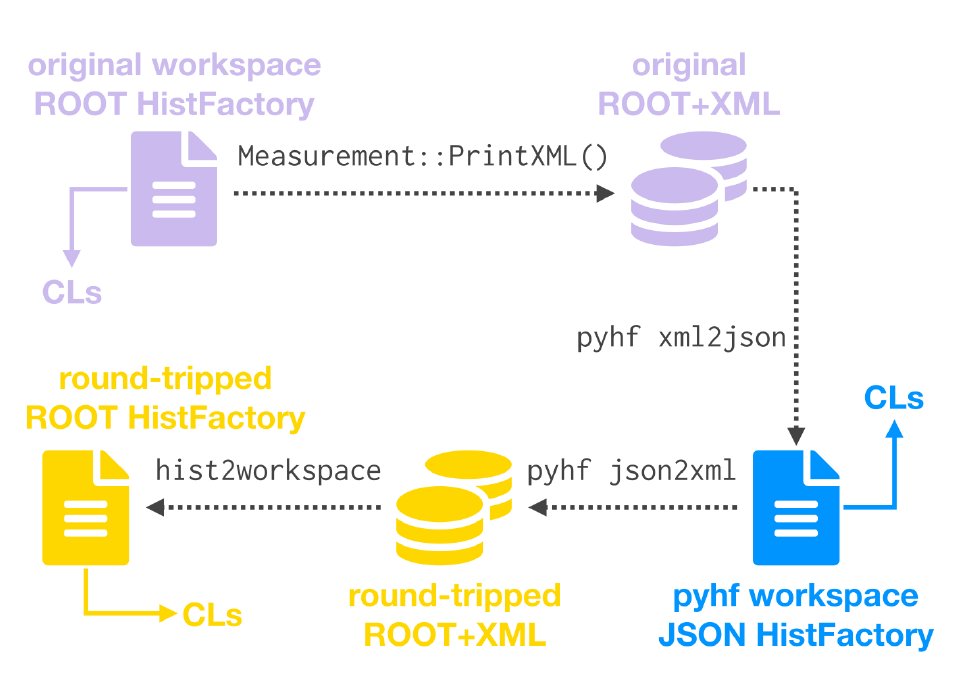
Figure 1: The diagram of the technical procedure to go from the original ROOT workspaces provided by the analysis team, to the JSON workspaces used by pyhf , and finally the round- trip ROOT workspaces. pyhf provides utilities to convert between two di ff erent HistFactory specification formats